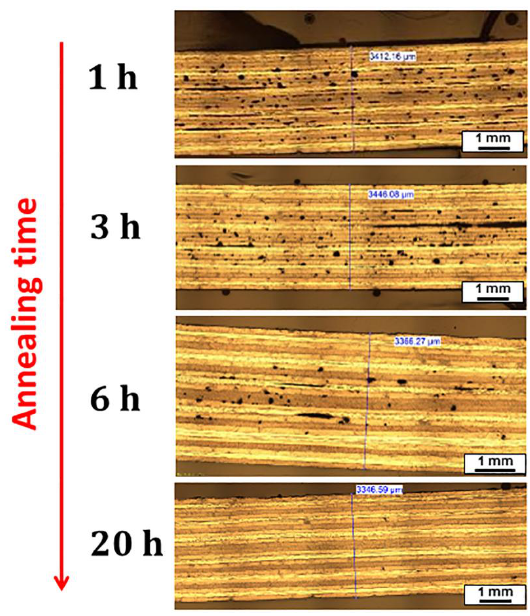
Figure 8. Optical microscopies of IR-heated blank laminates after annealing at 240 °C at different times.